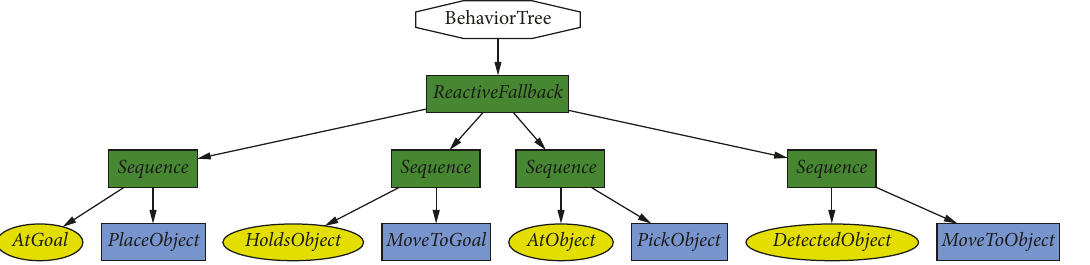
Figure 8: Result of step 3—robust logical-dynamical chain.